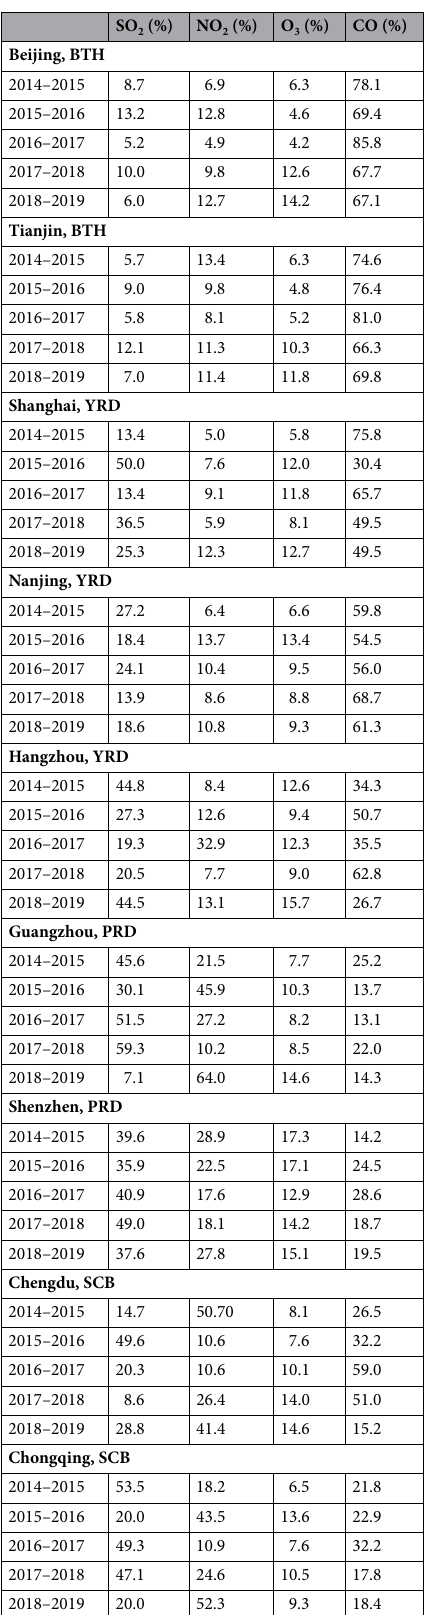
Table 1. FI of wintertime PM 10 in nine regional core cities in Scenario